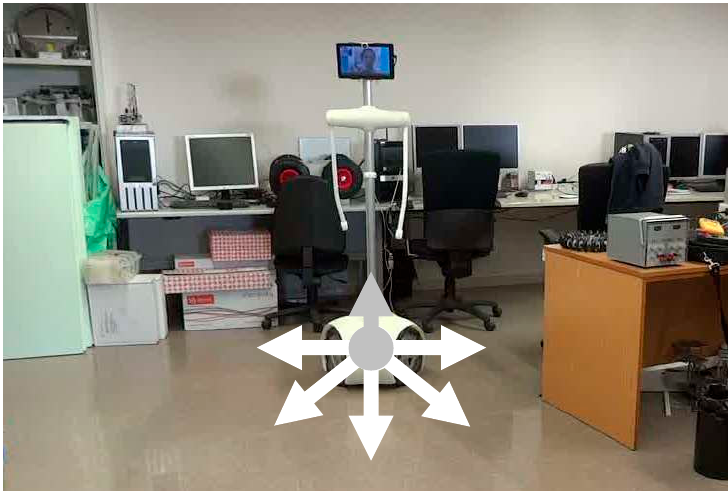
Figure 3. Representation of the direct motion capabilities of the APR.